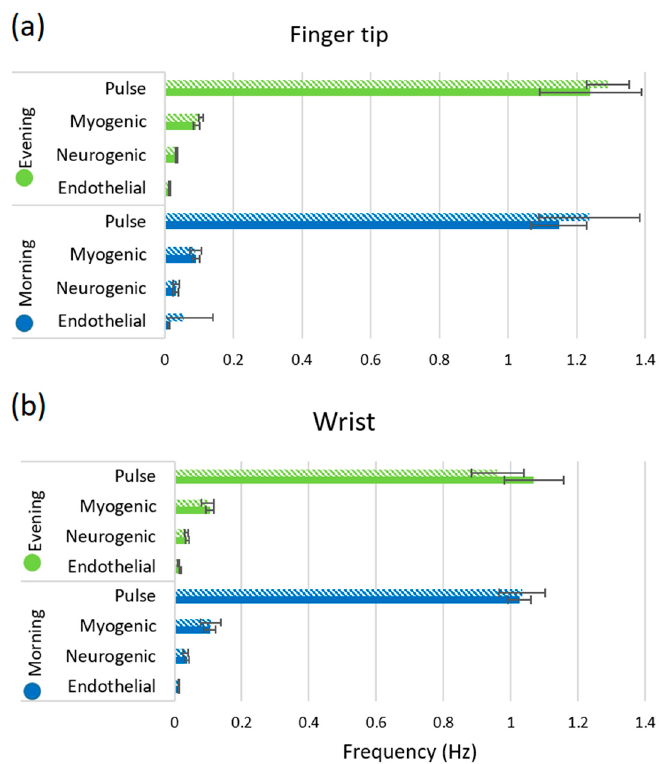
Figure 5. Maximum peak frequency with standard deviation of the endothelial, neurogenic, myogenic and pulse mechanism for non-smoker and smoker at ( a ) fingertip and ( b ) wrist. Solid bar denotes non-smoker and patterned bar denotes smoker.